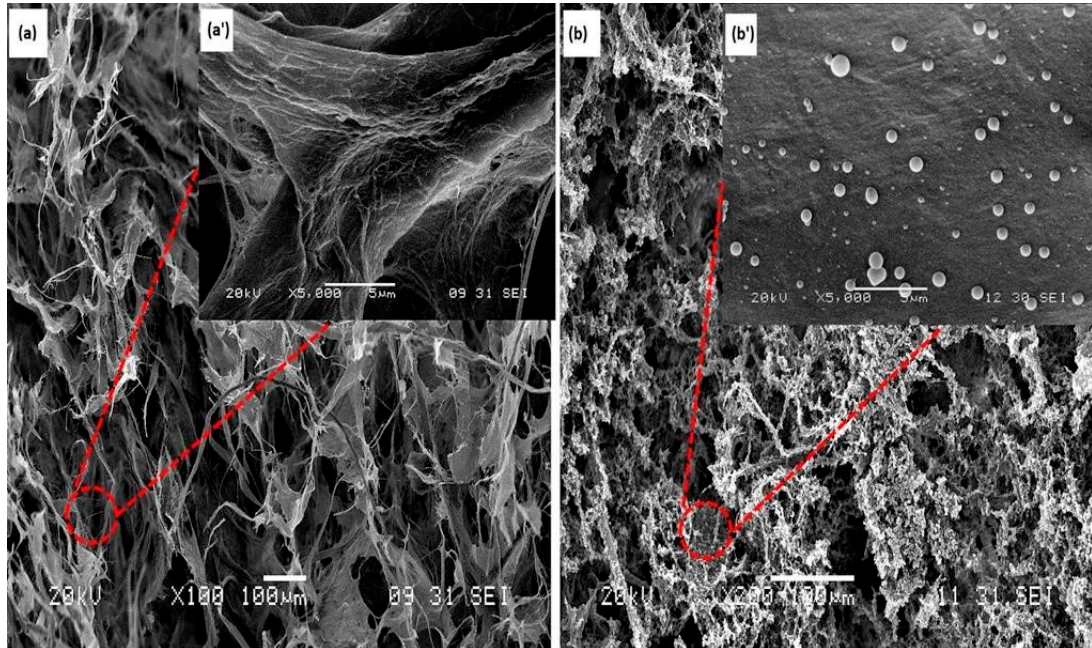
Figure 2. SEM images of the ( a ) neat cellulose nanofiber (CNF) aerogel; ( a’ ) magnified image of neat CNF aerogel; ( b ) silane-modified CNF aerogel; and ( b’ ) magnified image of silane-modified CNF aerogel.